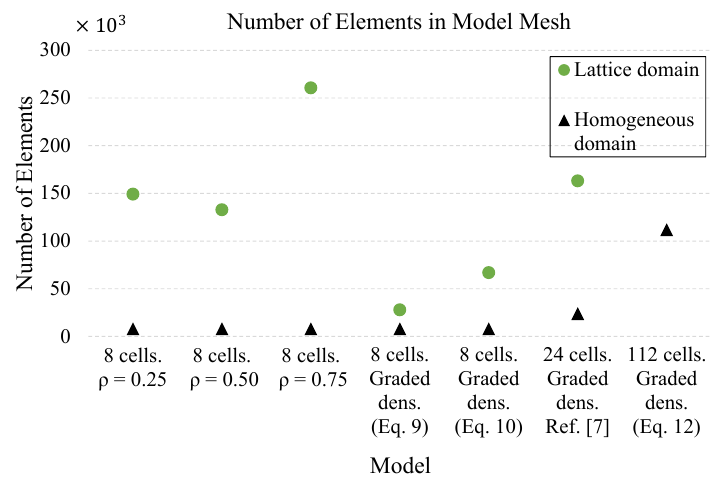
Figure 6. Number of elements in the FE meshes of lattice and simplified homogeneous domains.